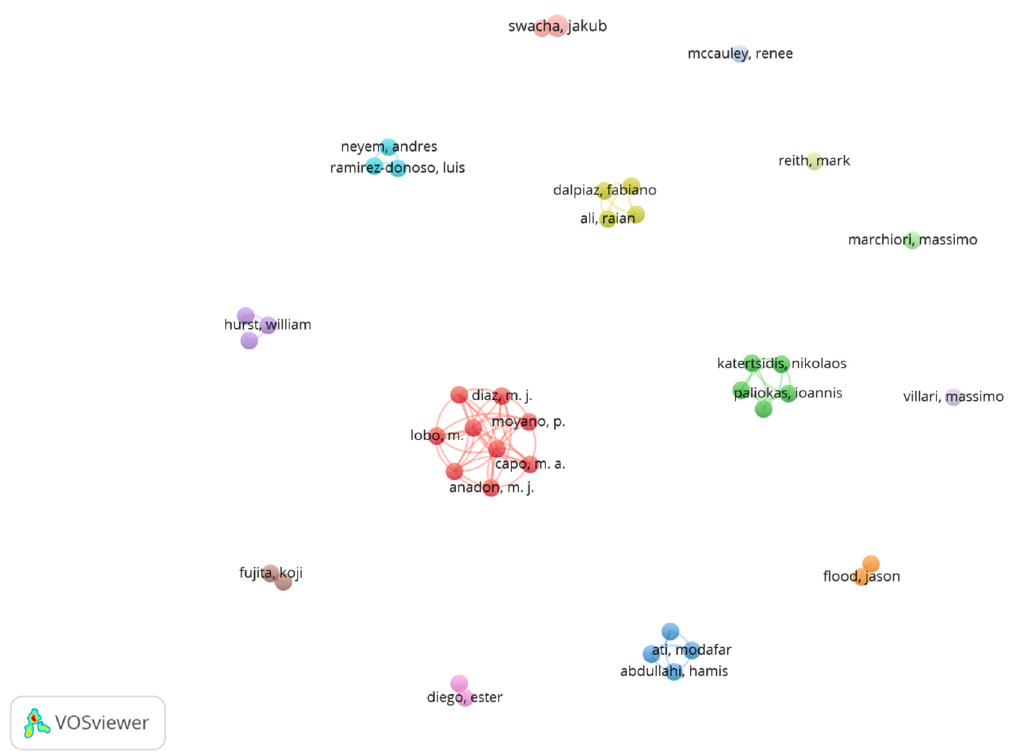
Figure 3. Mapping the scientific collaborations.